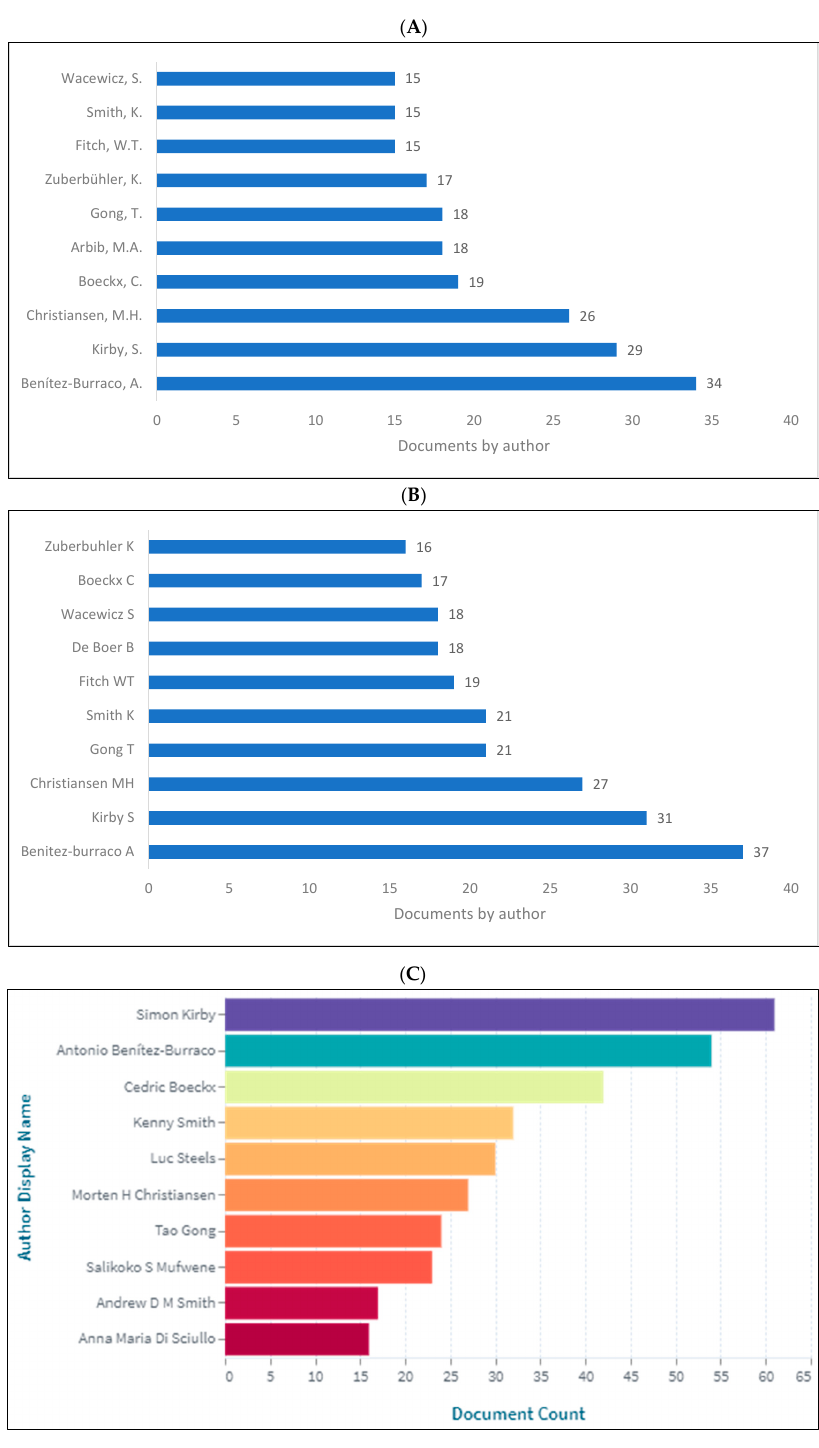
Figure 6. Knowledge production size in biolinguistics by research area. ( A ) (Scopus), ( B ) (WOS), ( C ) (Lens).